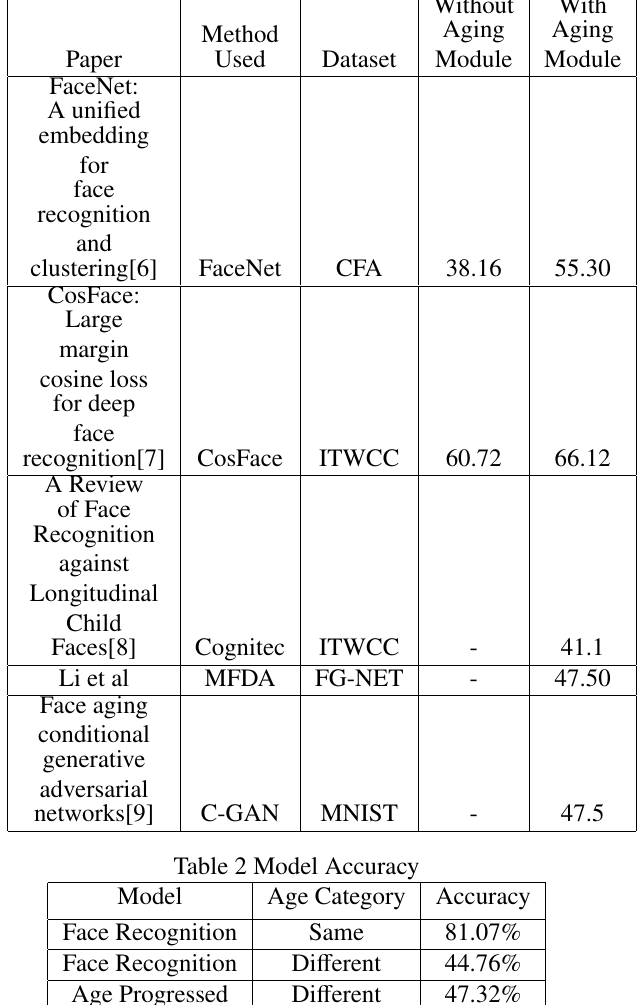
Table 1 Identification accuracy for previous work with and without the proposed feature aging